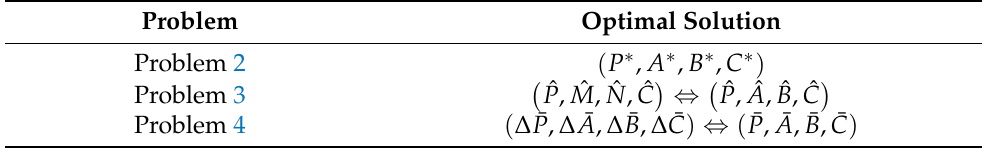
Table 1. Notation of optimal